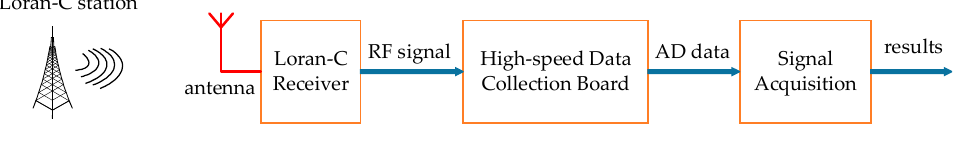
Figure 12. Effect of CRI on correlation peak amplitude and acquisition accuracy: ( a ) amplitude of correlation peak; ( b ) acquisition error.